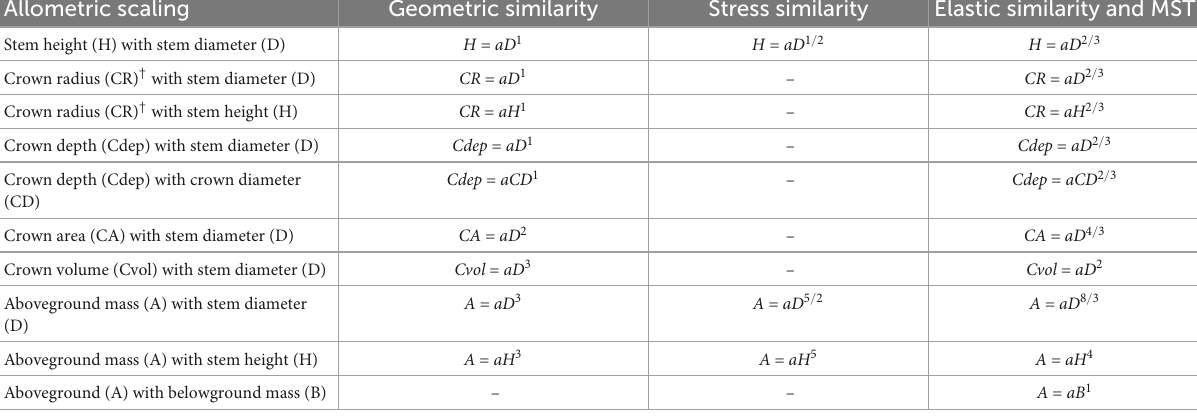
TABLE 1 Allometric scaling relationships among stem height, diameter at breast height, various crown dimensions and tree biomass and the theoretical expectations of the exponent of the geometric similarity, constant stress similarity, elastic similarity, and metabolic scaling theory (MST). Allometric scaling Geometric similarity Stress similarity Elastic similarity and MST